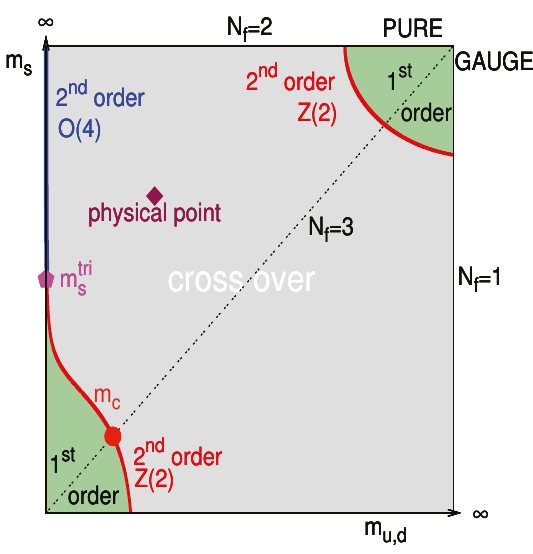
Figure 1 . The expected phase diagram in the quark mass plane m